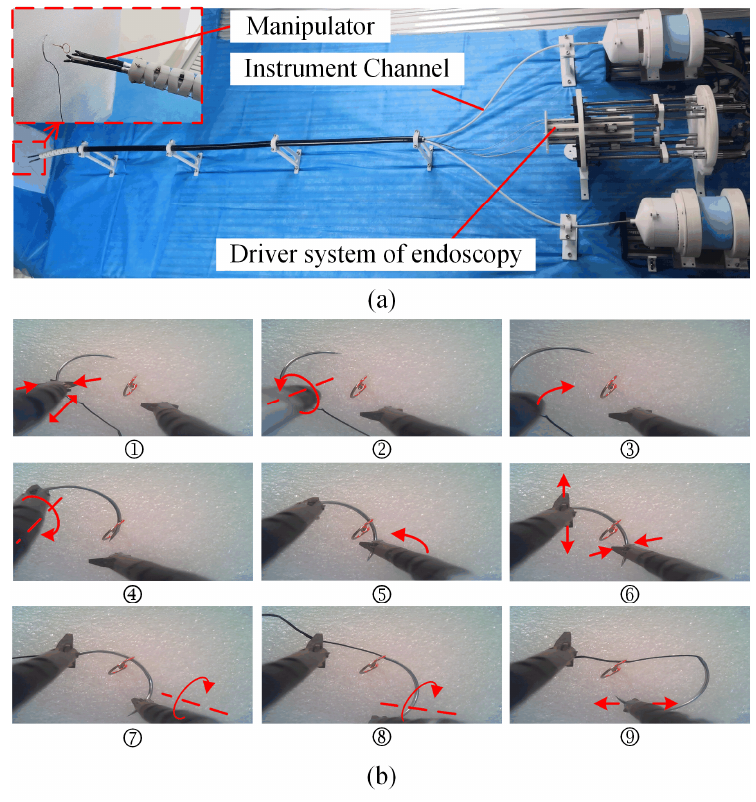
Figure 13. Performance test. ( a ) Experimental setup; ( b ) Operation process. The operation procedure is shown in Figure 13b. The left manipulator transmitted to the suture needle. The forceps began to close as they approached the needle (Figure 13b- 1 (cid:13) ). The suture needle was removed from the foam board using a counterclockwise rotation of the manipulator (Figure 13b- 2 (cid:13) ). The manipulator bent and rotated to bring the suture needle close to the metal ring (Figure 13b- 3 (cid:13) ). When the needle tip was close to the ring, the manipulator mainly rotated to make the suture needle pass through the ring (Figure 13b- 4 (cid:13) ). When the suture needle was halfway through the ring, the right manipulator bent to get close to the suture needle (Figure 13b- 5 (cid:13) ). When the right forceps approached the suture needle, the right forceps began to close and the left forceps began to open (Figure 13b- 6 (cid:13) ). After the right forceps captured the suture needle, the right manipulator rotated to make the suture needle pass through the metal ring (Figure 13b- 7 (cid:13) ). To avoid the interference between the suture needle and the metal ring, the right manipulator had to be accompanied by a bending motion while rotating (Figure 13b- 8 (cid:13) ). When the suture needle completely passed through the metal ring, the right clamp was opened and the entire experiment was completed (Figure 13b- 9 (cid:13)